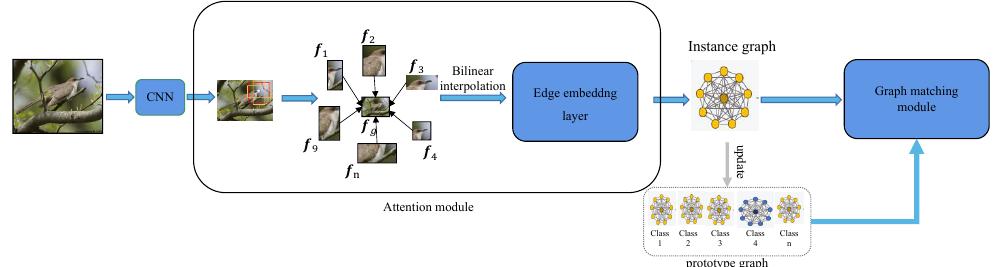
Figure 1. An overall illustration of the proposed GRML framework. It consists of two crucial modules, i.e., attention-focused and graph matching modules. The attention-focused module first locates local regions with different sizes and aspects that cover the most discriminative contents. Meanwhile, the graph matching module is used to explore information interactions to learn instance-level and category-level graph representation, as well as their matching to correct the noisy labels and exclude OOD